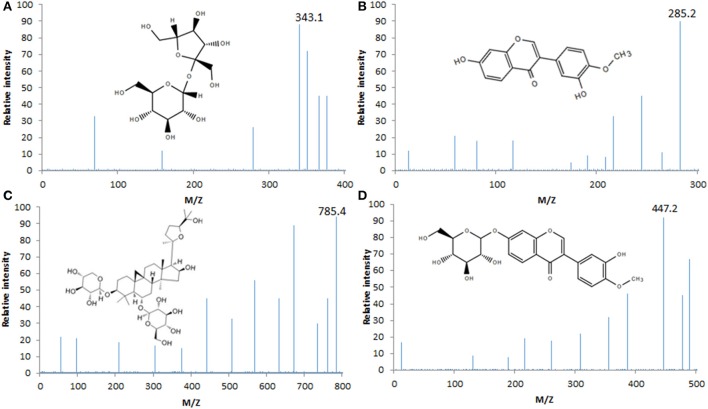
Analysis of LCQ mass spectrometer of AB ingredients. (A) The MW of sucrose was 343 in a [M+H]+ mode. (B) The MW of calycosin was 285 in a [M+H]+ mode. (C) The MW of Astragaloside IV was 785 in a [M+H]+ mode. (D) The MW of calycosin-7-glucoside was 447 in a [M+H]+ mode.